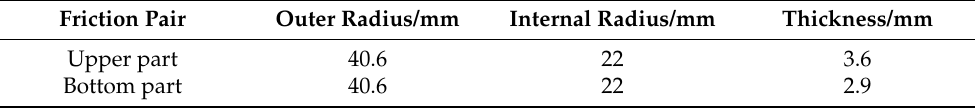
Table 2. Physical structure parameters of the friction pair.